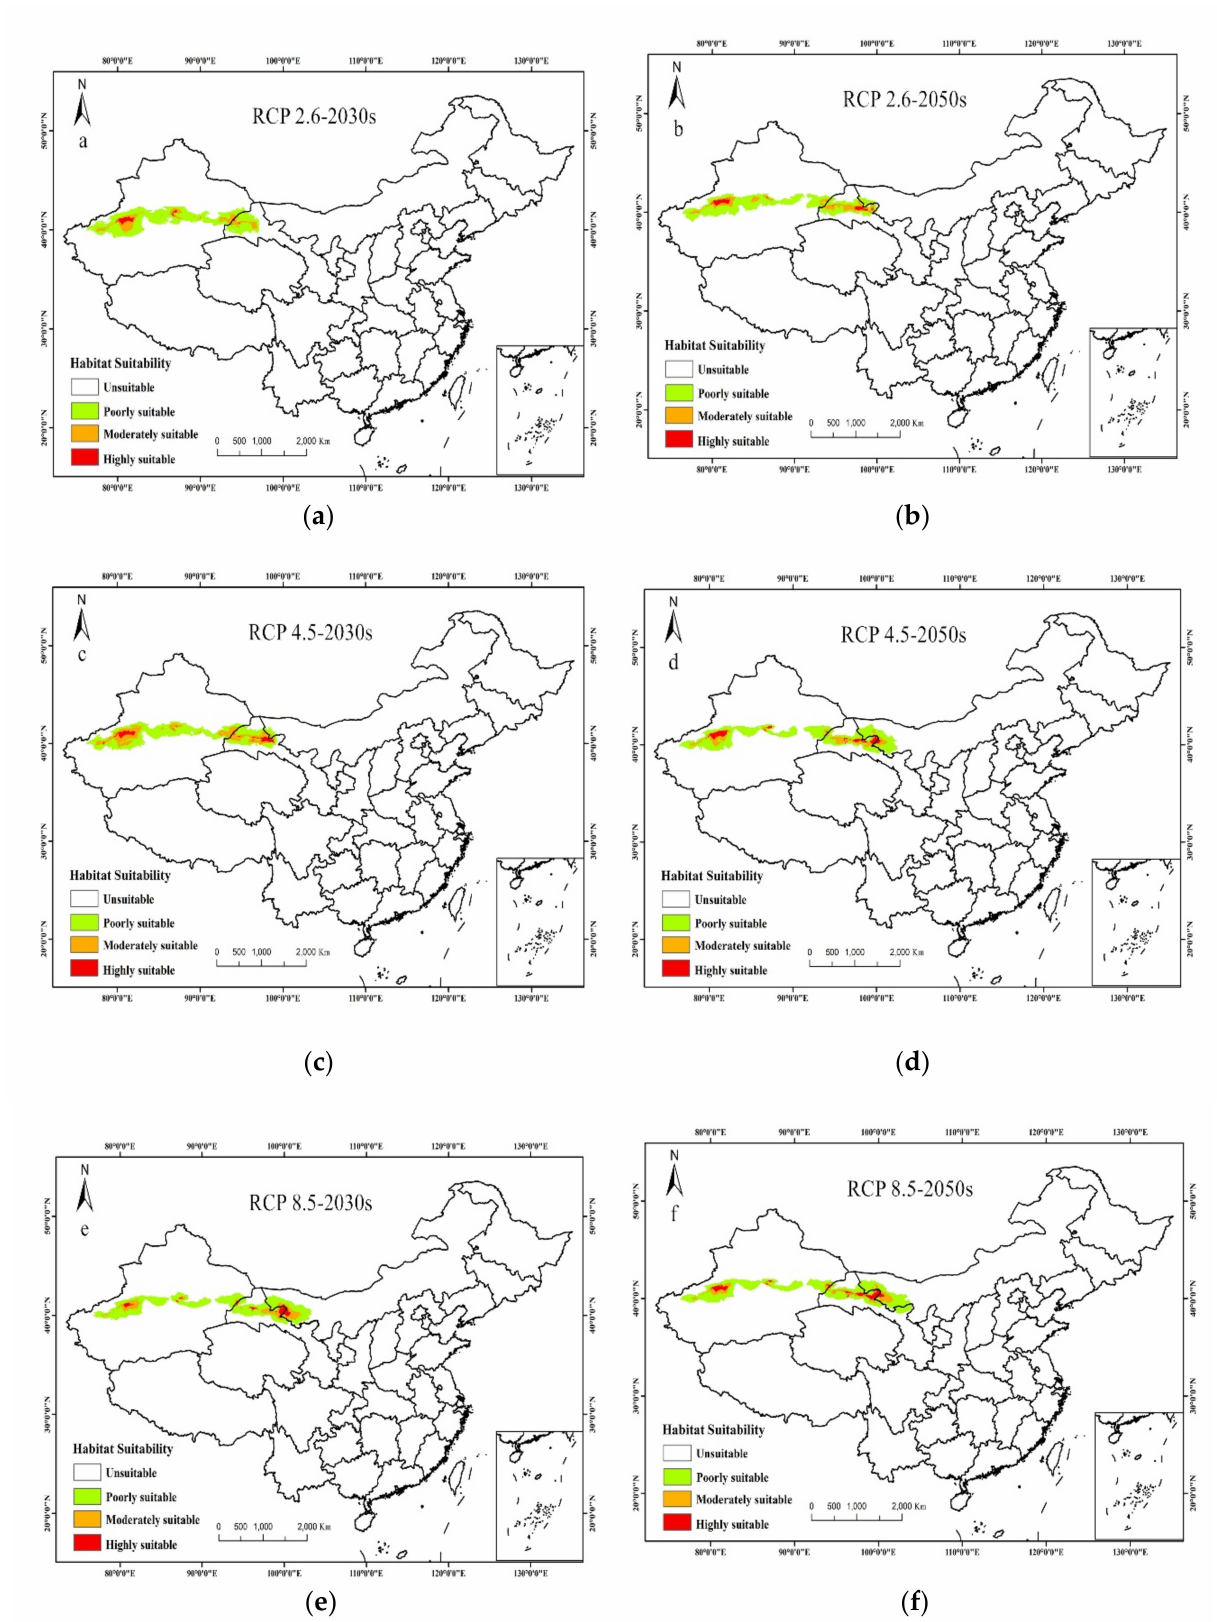
Figure 5. Future habitat distribution suitability of T. klimeschi . ( a , b ) future suitable habitats under RCP2.6 in 2030s and 2050s; ( c , d ) future suitable habitats under RCP4.5 in 2030s and 2050s; ( e , f ) future suitable habitats under RCP8.5 in 2030s and